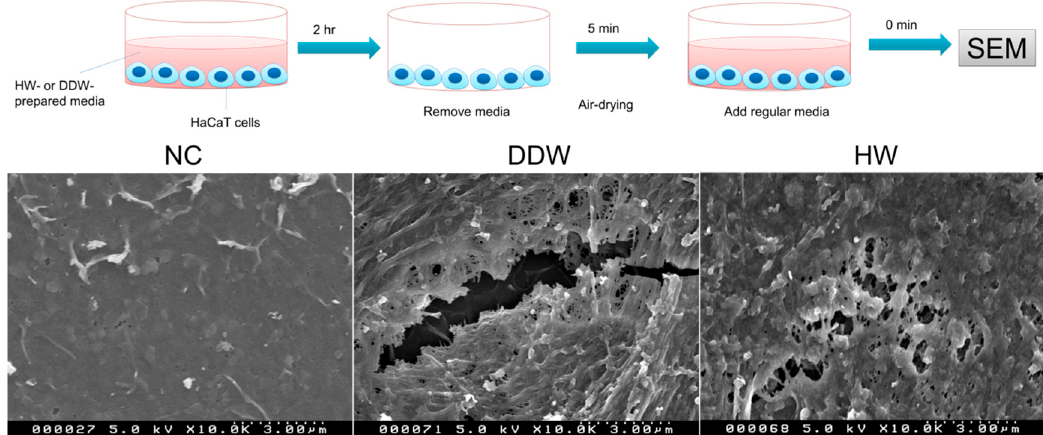
Figure 5. Effects of HW on hypohydration-induced membrane damage in HaCaT keratinocytes.